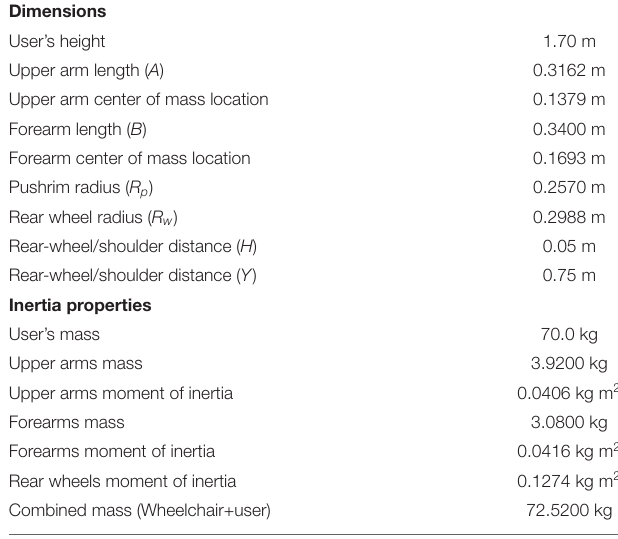
TABLE 1 | Adopted model